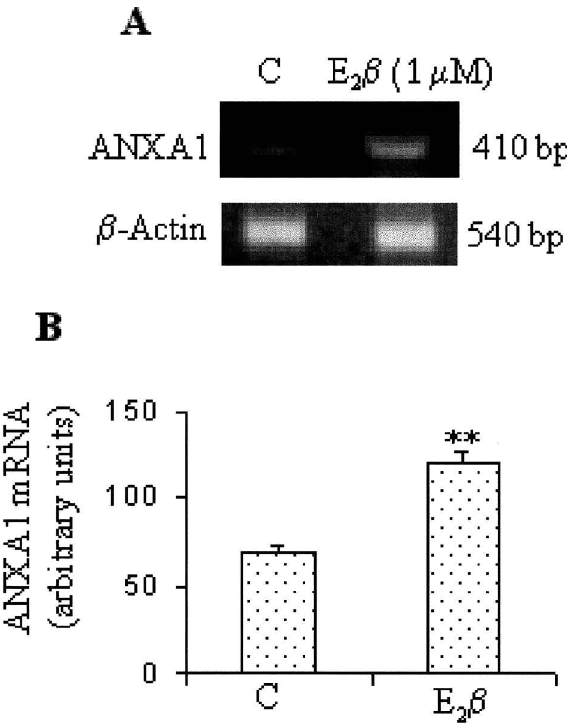
FIG. 2. Effect of E2 b on ANXA1 mRNA synthesis in CCRF- CEM cells. Cells were incubated in the absence (control, C) and in the presence of E 2 b (1 m M) for 30min (A). The bands were quantified with an image analyser (B). ANXA1 mRNA was detected by RT-PCR with a pair of primers specific for a fragment of ANXA1 mRNA. The data shown are an average of three independent experiments. Values are mean±SD, ** p < 0.01 as determined by Student’s two-tailed unpaired t